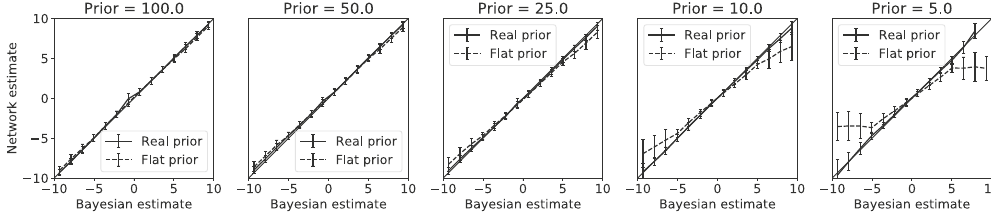
Figure 8. Network learns to incorporate prior knowledge optimally. Stimuli were drawn from Gaussian 100, 50, 25, 10, 5 ). During testing, stimuli in the range 10, 10 priors with different variances (i.e. σ 2 p ∈ [− ] 100 prior effectively uniform. The posterior that the network learned is were presented, making the σ 2 p = plotted against the optimal Bayesian estimates that accounts for the prior (solid line), or that ignores the prior 100 both Bayesian estimates are similar in the probability, i.e. a uniform prior (dashed line). While for σ 2 p = 5 . The network estimates match the 10, 10 range , there is a big difference between both estimates for σ 2 p = [− ] Bayesian estimates accounting for the prior distribution, but not Bayesian estimates for the prior distribution. The network thus learns to incorporate the prior knowledge correctly. Error bars represent standard deviation over the validation trials.